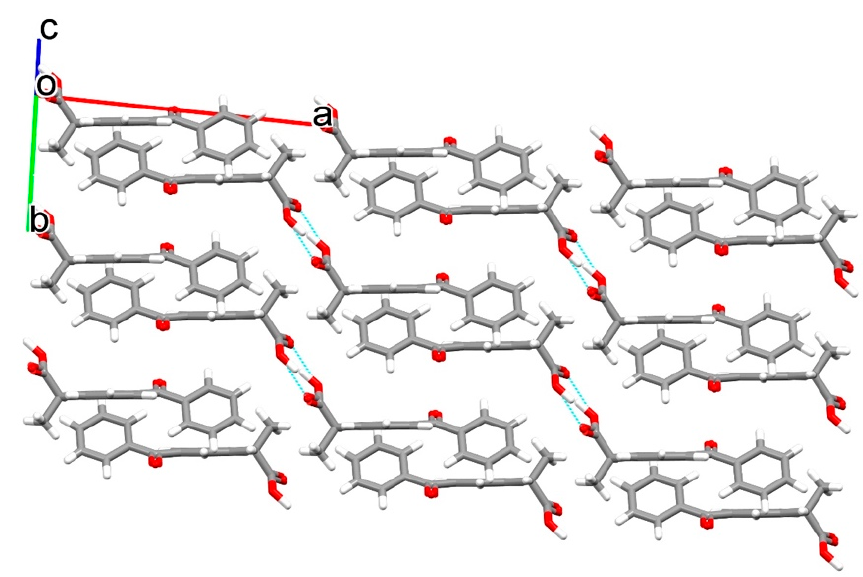
Figure 9. Crystal packing of ketoprofen (KEMRUP) [32] in a 3 × 3 structure showing carboxylic acid dimers instead of the layered structure. One missing hydrogen atom was calculated geometrically.